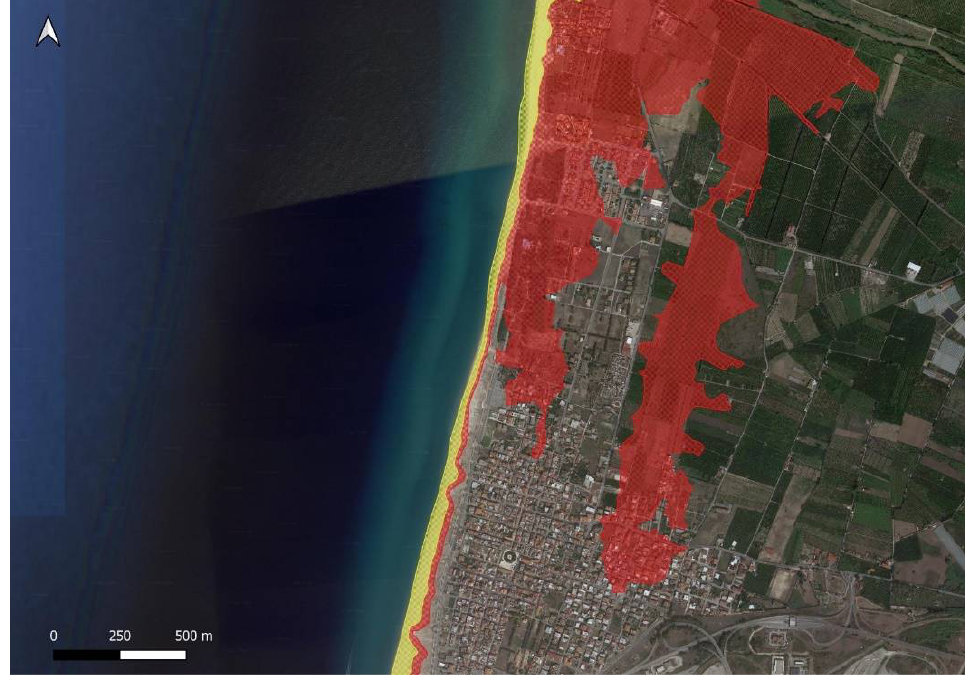
Figure 8. San Ferdinando. Schemes follow the same formatting. Legend: Yellow, the floodable area in the current scenario; red, the floodable area in the future scenario.